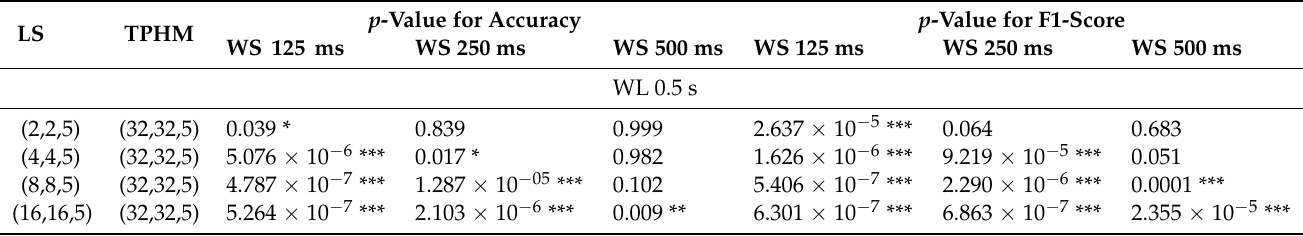
Table 4. Comparison of utility scores between two groups (topology preserved head-maps and each latent space) for a population size of 32 in a paired one-sided Wilcoxon signed-rank test with α =